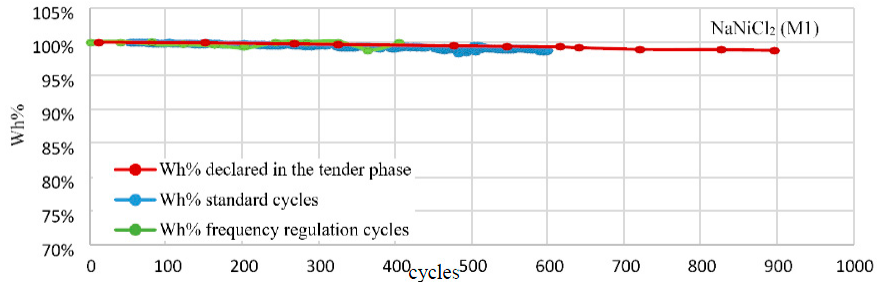
Figure 13. NaNiCl 2 (M1) technology: comparison between the expected ageing, declared in the tender phase, and the ageing after the standard and frequency regulation cycles.